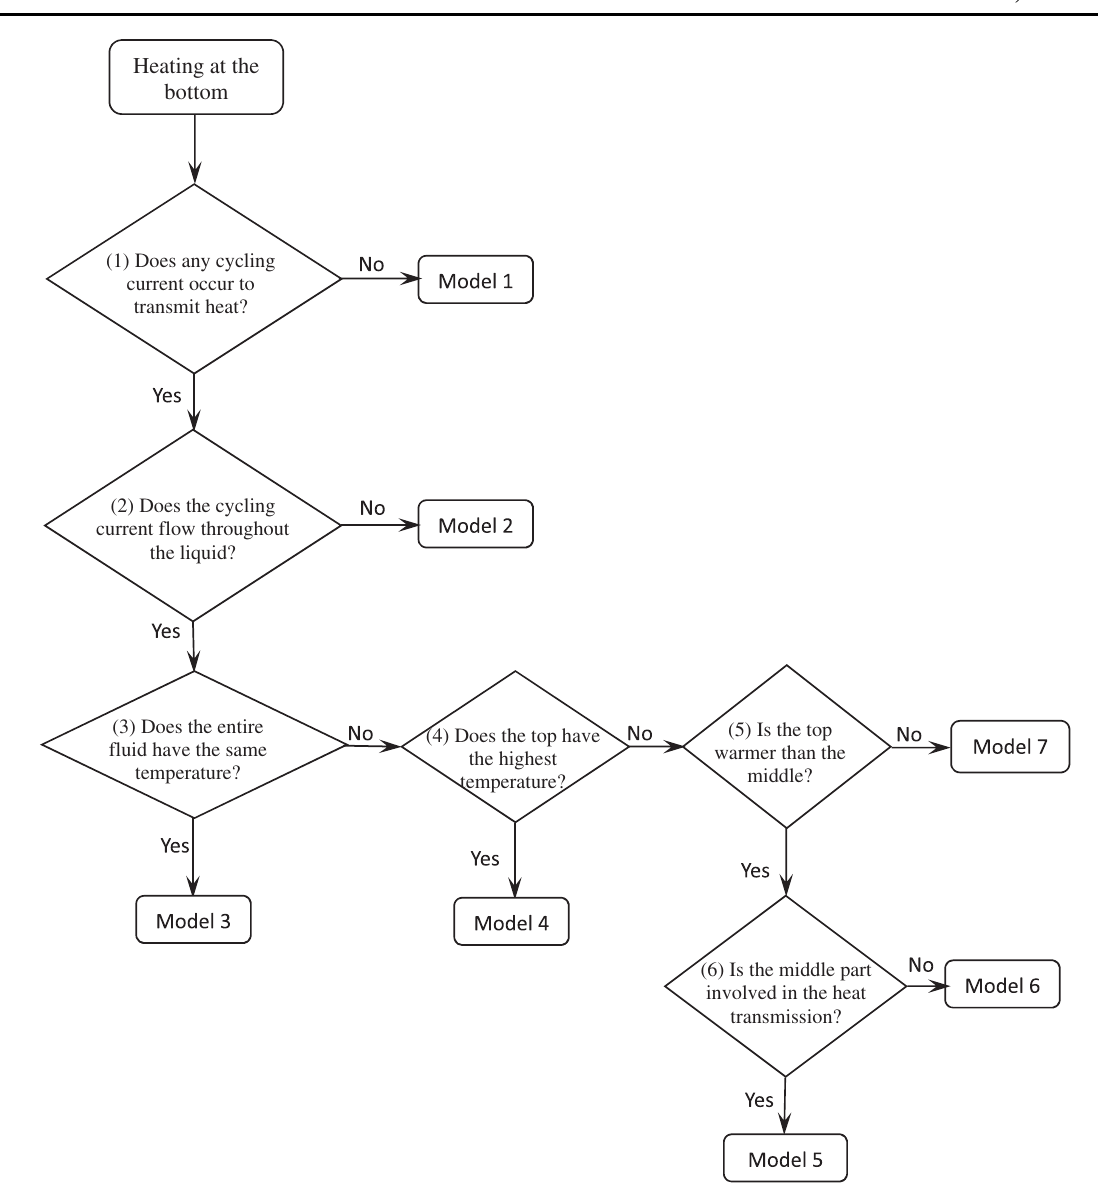
FIG. 3. A framework to differentiate the seven